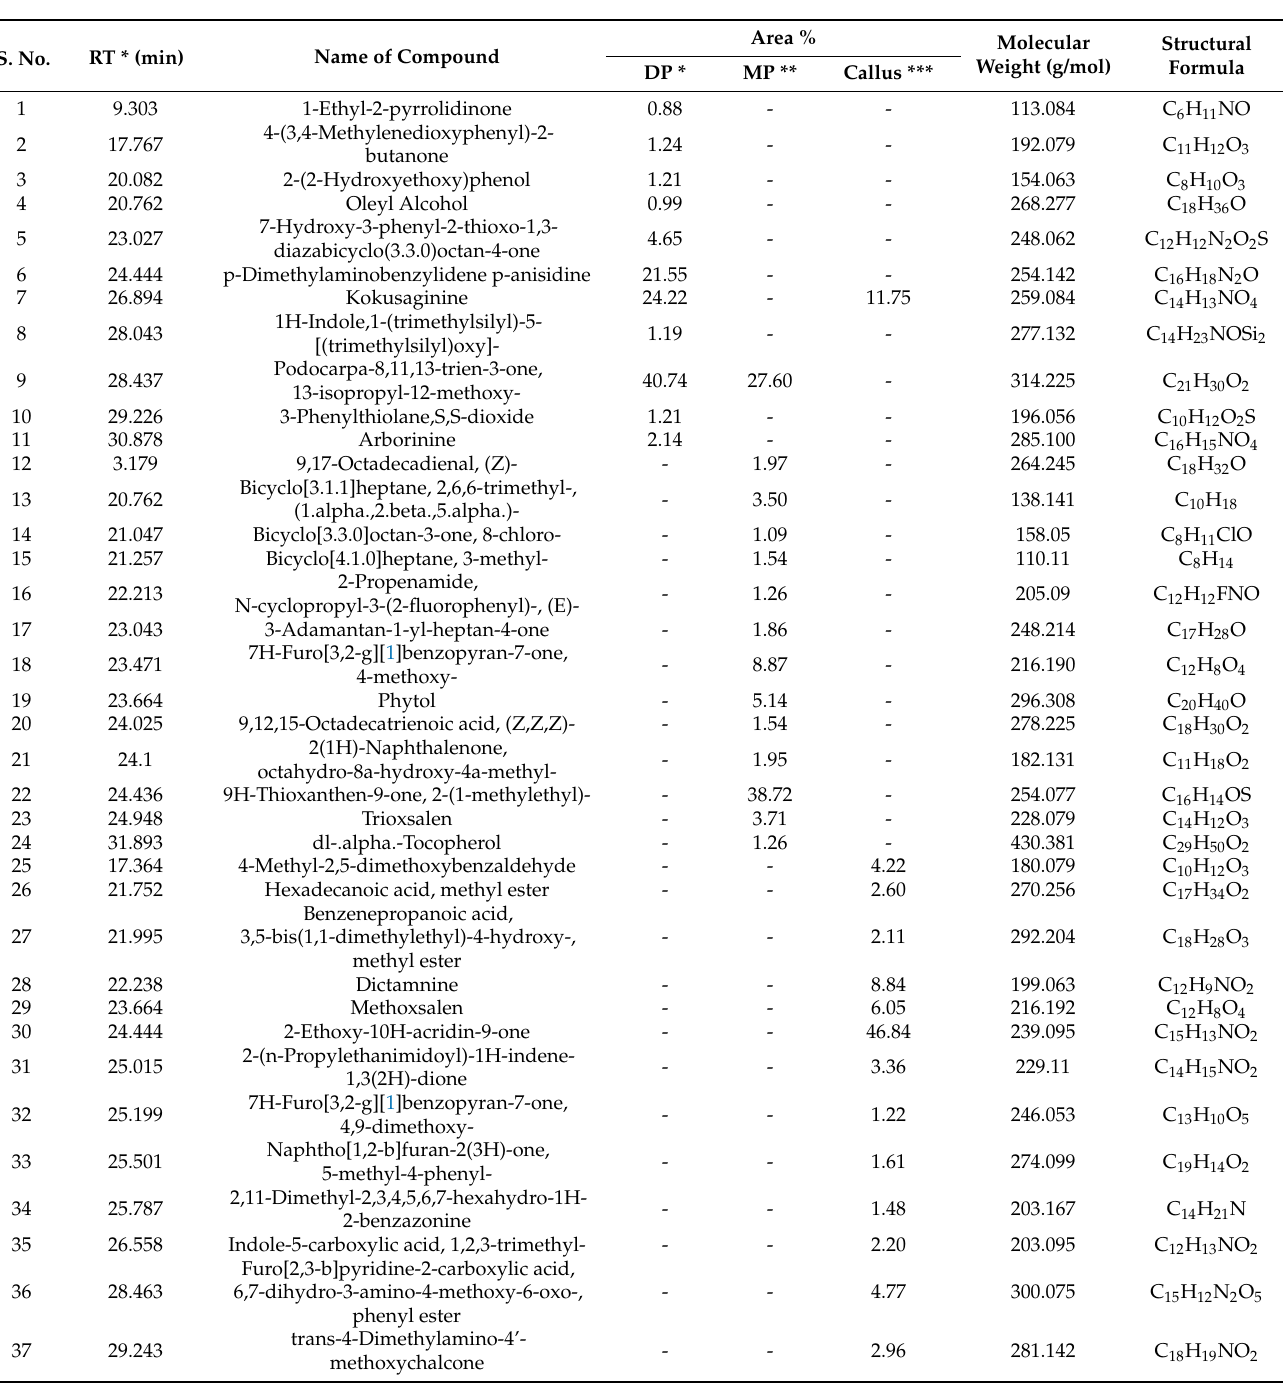
Table 6. GC–MS analysis of R. chalepensis methanol extracts of the donor plant growing in soil in the botanical garden, ex-vitro-established micropropagated plants, and callus obtained from MS + 2,4-D (10 µ M) + BA (1.0 µ